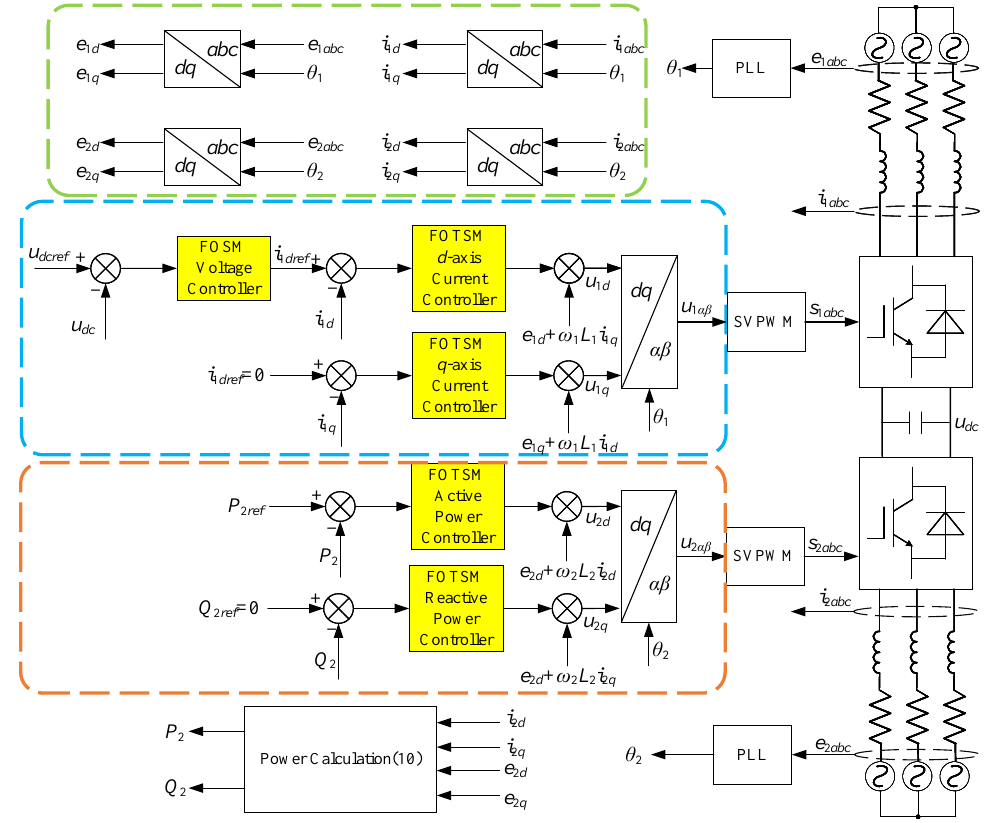
Figure 4. Block diagram of the control scheme of the